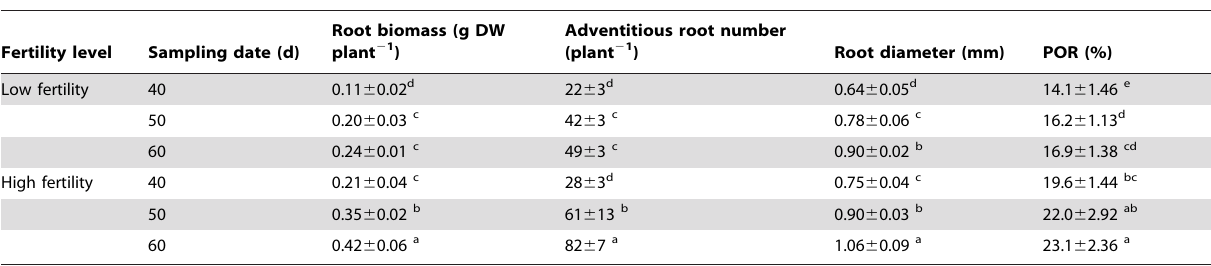
a Values represent means (means 6 SDs), and different letters in the same column indicate a significant difference at the p , 0.05 level. Data were pooled for n=3, except for adventitious root diameter (n=12), which was measured at the middle of each root selected for the average length of the whole root.